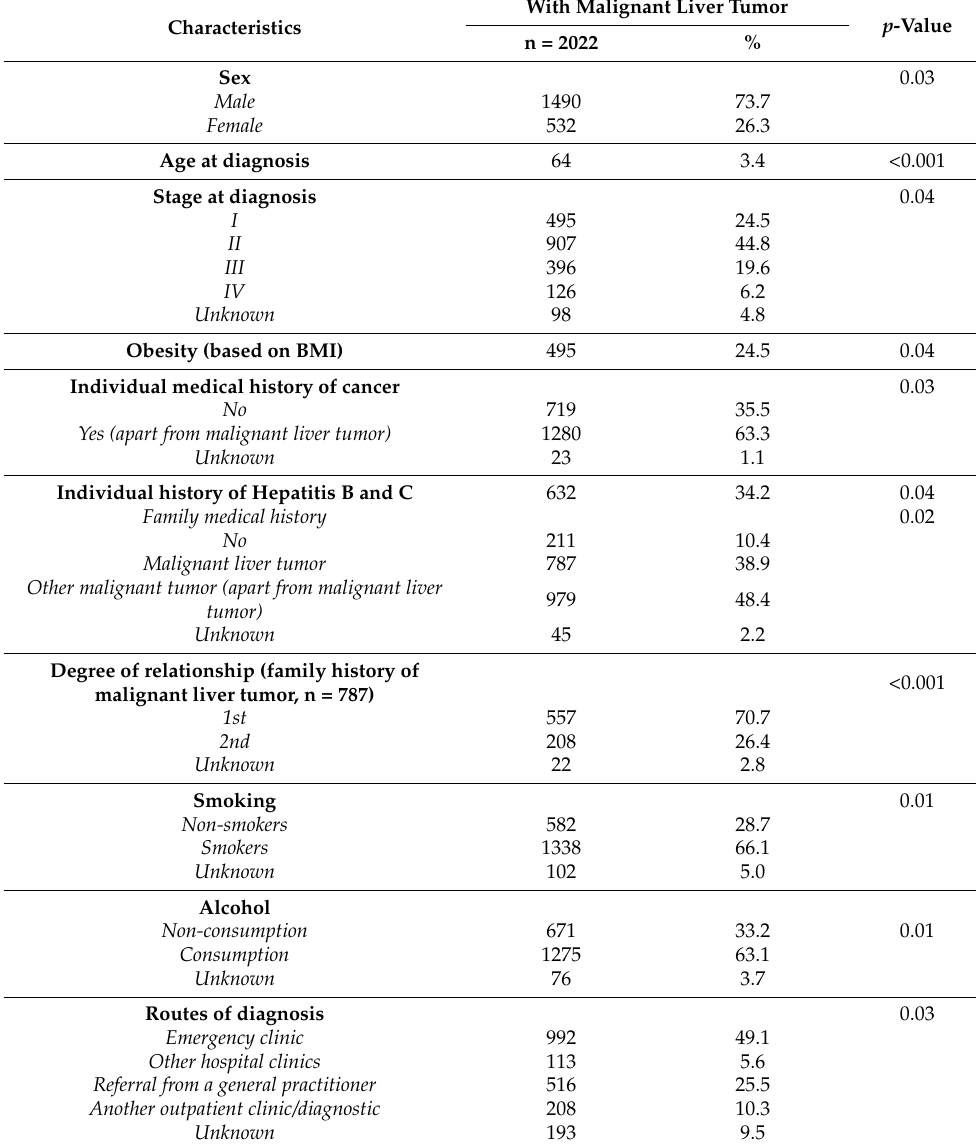
Table 1. Demographic and medical profile of patients with malignant liver tumors in Crete, for the time period of 1992–2013 (n =